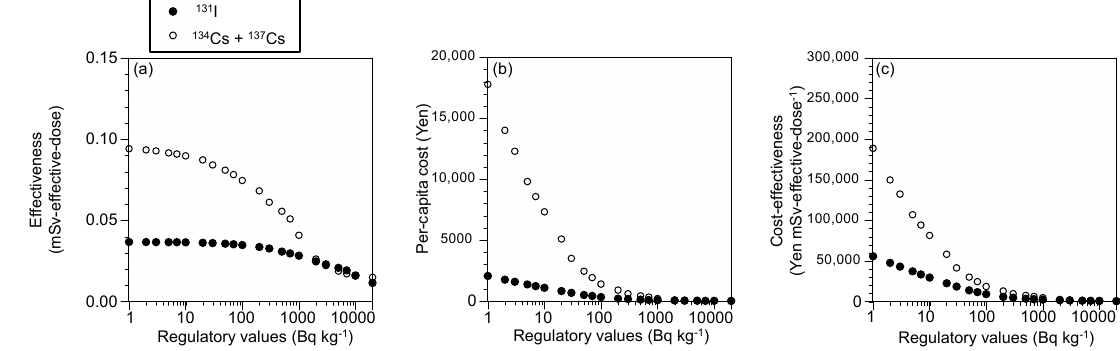
Figure 3. Cost and effectiveness of restricted food distribution for each regulatory value: ( a ) reduction in effective doses, ( b ) per-capita cost, and ( c ) cost effectiveness. Men, ≥ 19 year, actual emission conditions, Case 1.